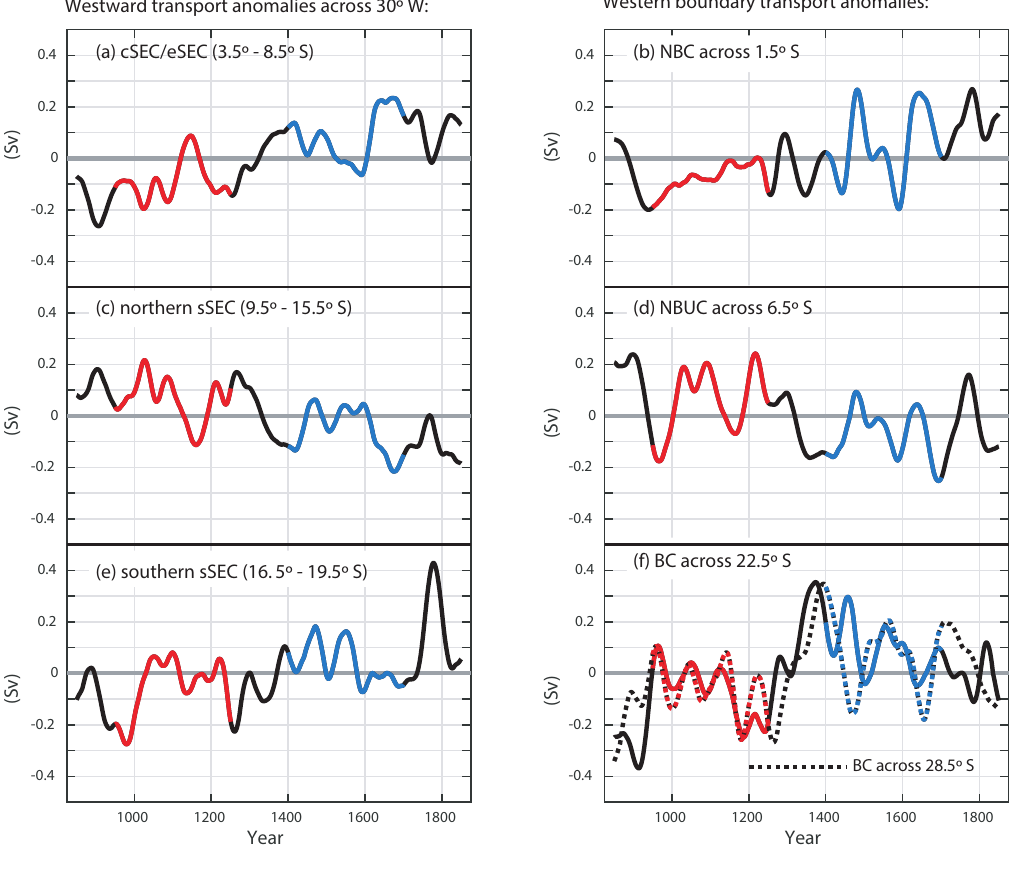
Figure 5. Horizontal volume transport anomalies time series. Low-passed (30-year), standardized anomalies time series of the volume transports above 200 m. (Left column) Westward transports across 30 ◦ W at different latitudinal bands from north to south: ( a ) cSEC/eSEC between 3.5 ◦ S and 8.5 ◦ S, ( c ) northern sSEC between 9.5 ◦ S and 15.5 ◦ S, and ( e ) southern sSEC between 16.5 ◦ S and 19.5 ◦ S. (Right column) Western boundary transports fed by the westward transports: ( b ) northward NBC across 1.5 ◦ S, ( d ) northward NBUC transport across 6.5 ◦ S (solid lines) and the basin-integrated MOC streamfunction across the same latitude (dashed lines), and ( f ) southward BC transport across 22.5 ◦ S (solid lines) and across 28.5 ◦ S (dashed lines). The MCA period is marked in red, while the LIA is marked in